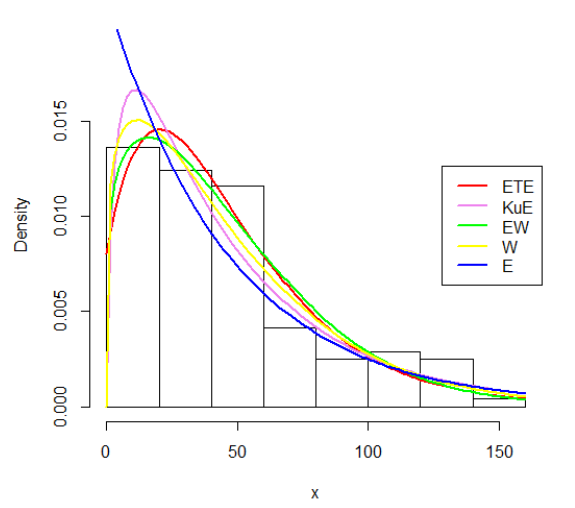
Figure 8 – Fitted pdf plots of second data